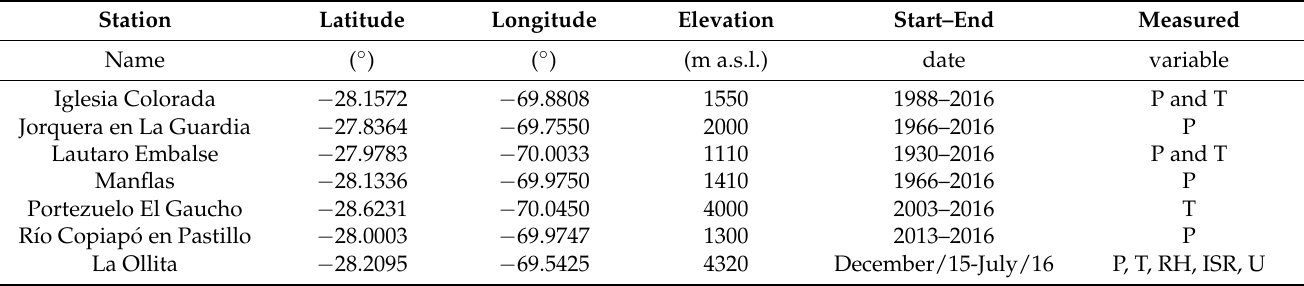
Table 1. Automatic weather station (AWS) network used in this study. P: Precipitation, T: Temperature, RH: Relative humidity, ISR: Incident shortwave radiation, U: Wind